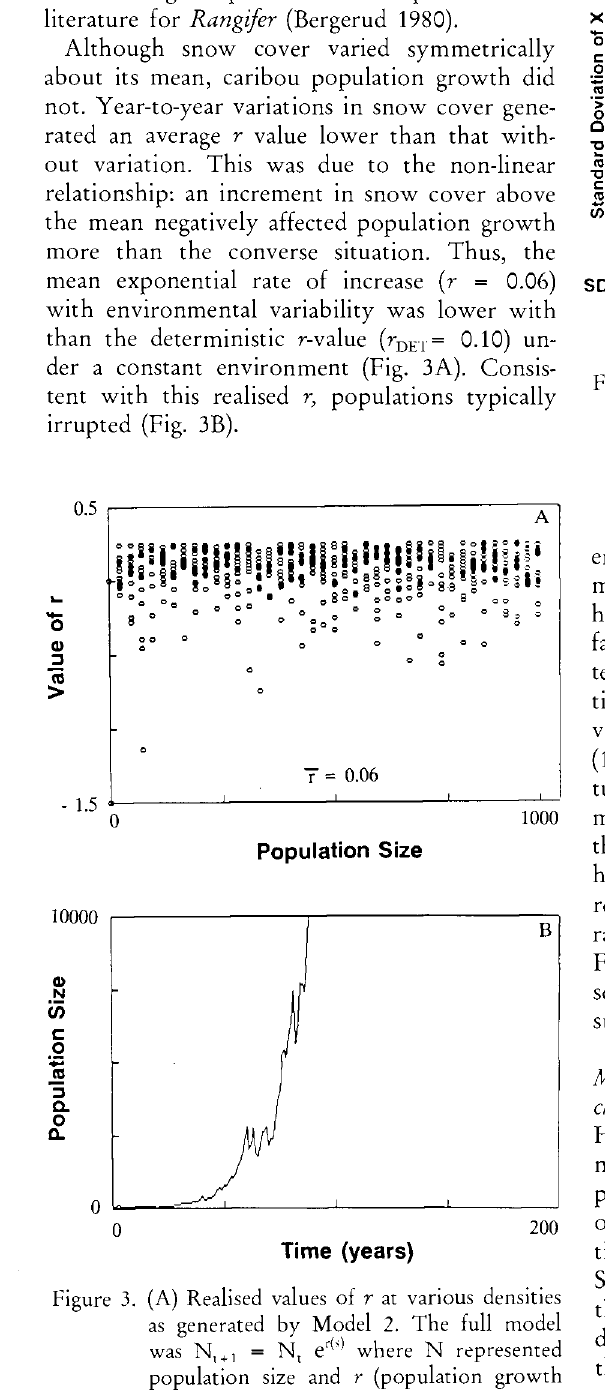
Figure 3. (A) Realised values of r at various densities as generated by Model 2. The full model was N I + 1 = N t e r(s) where N represented population size and r (population growth rate) was a stochastic function of snow as depicted in Fig. 2. (B) Typical trajectory of a population under Model 2.